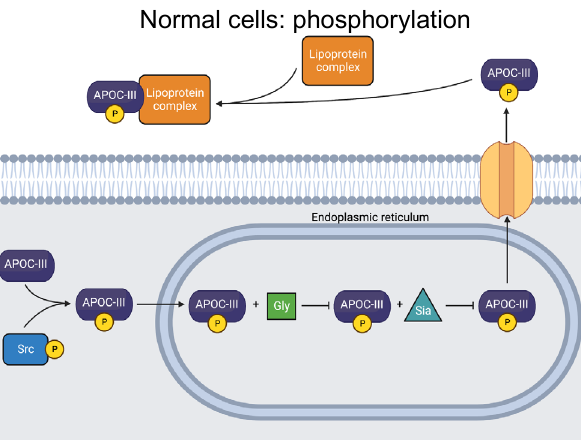
Figure 3. Diagram showing O-glycosylation, sialylation, phosphorylation, and extracellular transport of APOC-III. ( A ) APOC-III is O-glycosylated and sialylated in the endoplasmic reticulum [76,77]. After extracellular transport, it becomes a constituent of lipoproteins, regulating lipid transport and metabolism [71]. ( B ) Alternatively, T74 is phosphorylated, precluding O-glycosyla- tion [31]. ( C ) . The mutation T74A abolish es the O-glycosylation and phosphorylation site